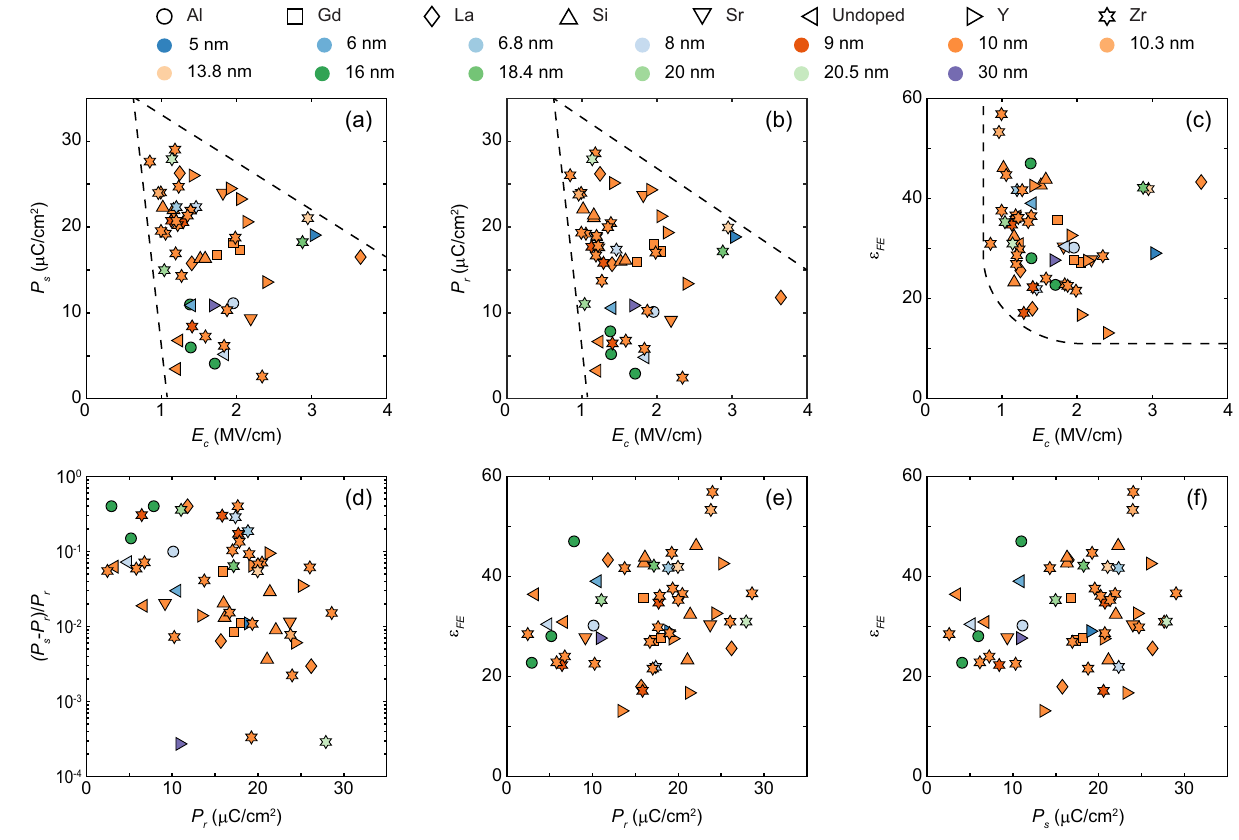
Figure 6. Ferroelectric parameters extracted from the literature for Al-doped 6,7 , Gd-doped 8 , La-doped 9 , Si-doped 1,10–12 , Sr-doped 13 , Y-doped 14,15 , Zr-doped 4,10,16–26 , and undoped 4,5 HfO 2 thin films, where E c is defined as the average of E c + and | E c − | . ( a ) Saturated polarization P s vs. coercive field E c . ( b ) Remnant polarization P r vs. coercive field E c . ( c ) Relative linear dielectric constant ε FE vs. coercive field E c . ( d ) ( P s - P r )/ P r vs. remnant polarization P r . ( e ) Relative linear dielectric constant ε FE vs. remnant polarization P r . ( f ) Relative linear dielectric constant ε FE vs. saturation polarization P s